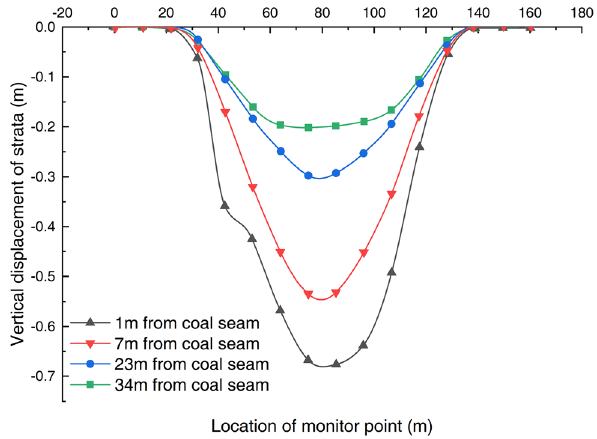
Fig. 5 Subsidence curves of overlying strata